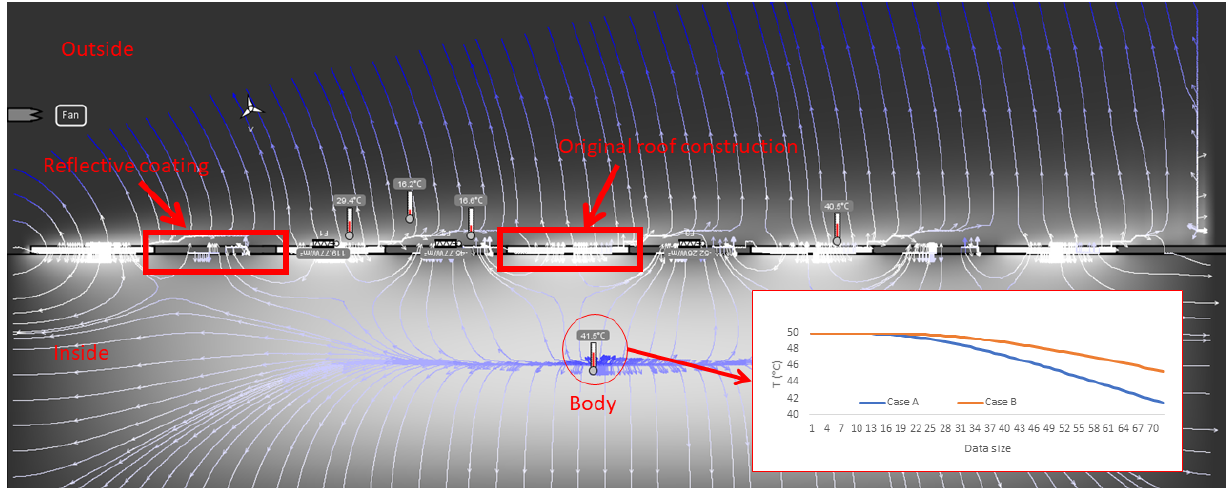
Figure 15. Transient simulation results for the 2D heat transfer model with and without segments reflective coating. Case A: Zebra-stripes strategy and Case B: reflective coating covered the entire surface. Own elaboration.